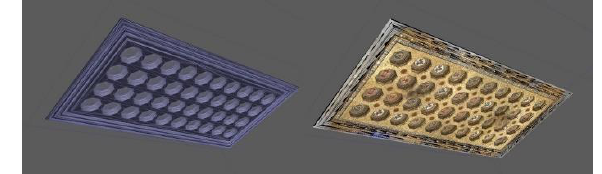
Figure 10. In LOD1.5 photogrammetry textures are applied to a modelled mesh as seen here with the Senate Ceiling.